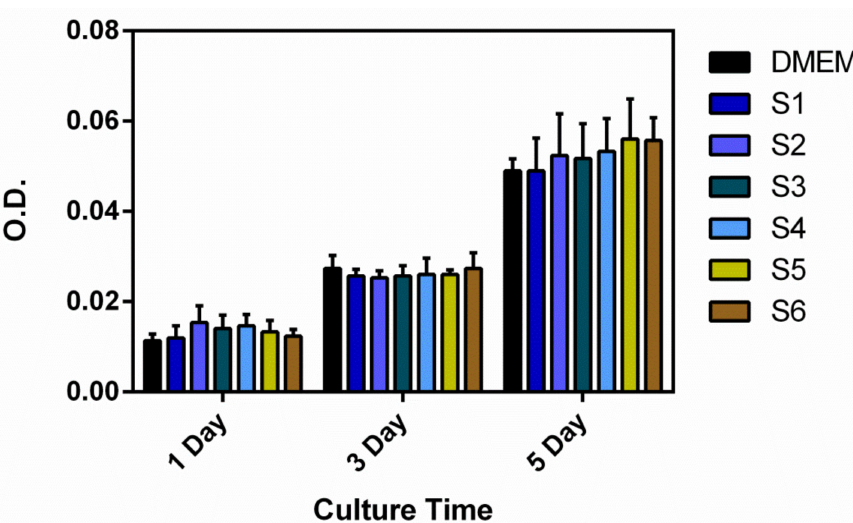
Figure 4. In vitro cytotoxicity of MG-63 cell lines after culturing in the synthesized HA samples (S1–S5) and HA derived from carp scales (S6) and DMEM for 1, 3 and 5 days.